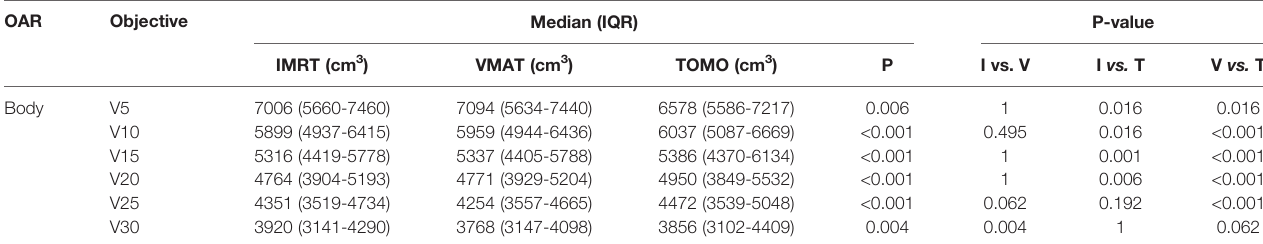
TABLE 10 | Low-dose radiation volume of IMRT, VMAT and TOMO in T 3-4 NPC patients.